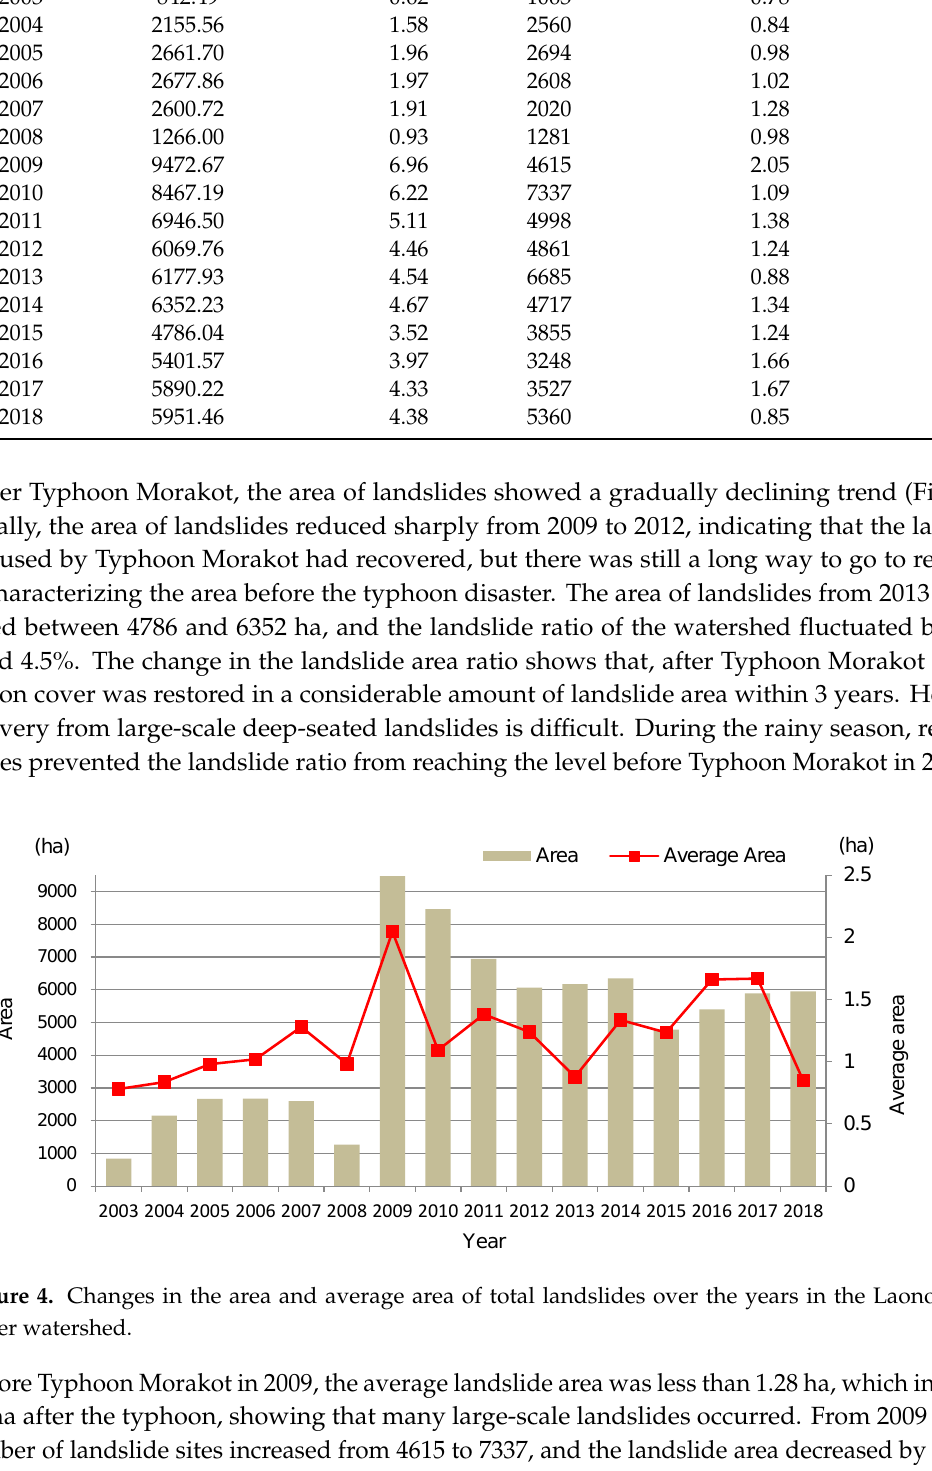
Table 3. Statistic results derived from each model. Tested Model